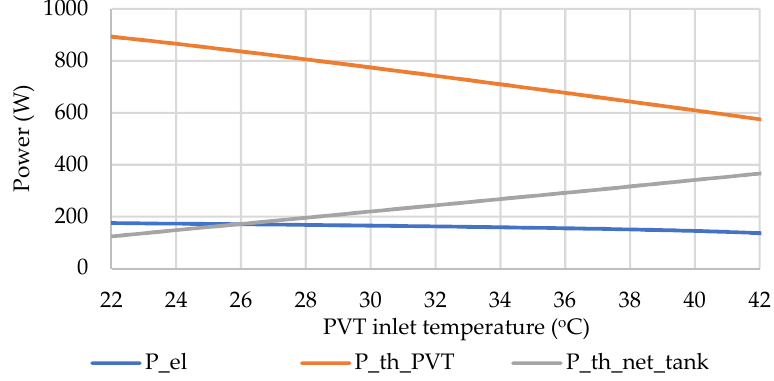
Figure 14. Instantaneous power versus PVT inlet temperature.